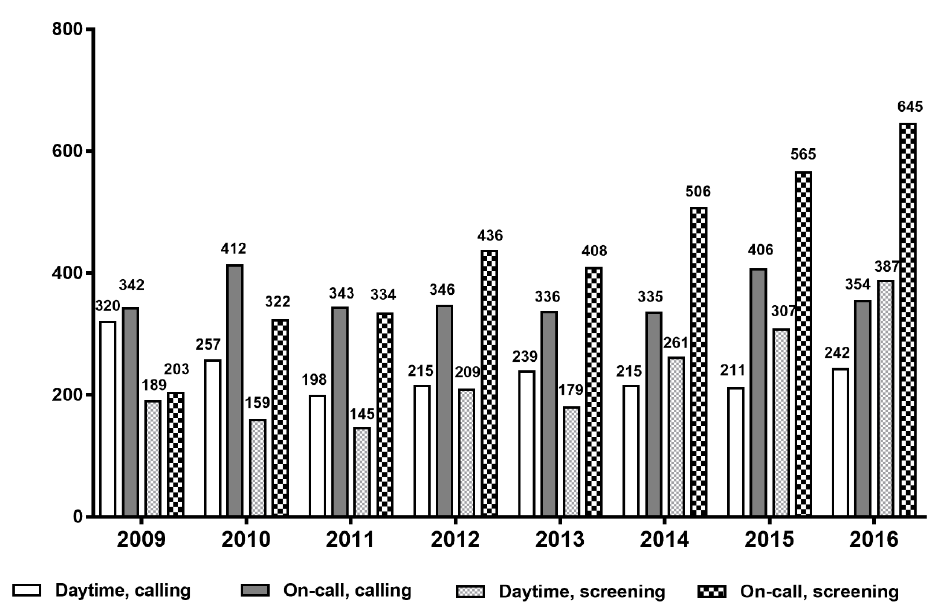
Figure 2 . The number of RRT events per year since 2009. Overall RRT events increased from 1055 in 2009 to 1627 in 2016. The total number of RRT activations by screening in 2016 was 2.63-fold higher than that in 2009. Data are presented as number of events.